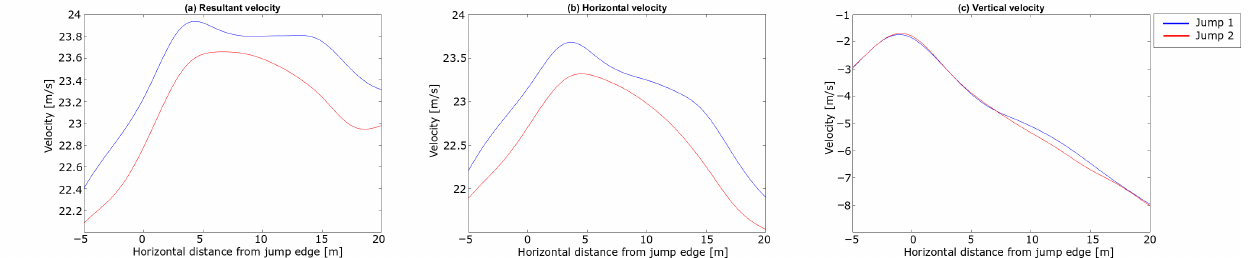
Figure 10. Velocity components of the CoM in the take-off and early flight phase for the jumps in the case study. ( a ) shows the resultant velocity v , ( b ) the horizontal velocity v x and ( c ) the vertical velocity v y . The horizontal length from the in-run edge is shown on the x-axis and velocity is shown on the y-axis. A negative sign on the x-axis indicates the area before take-off.